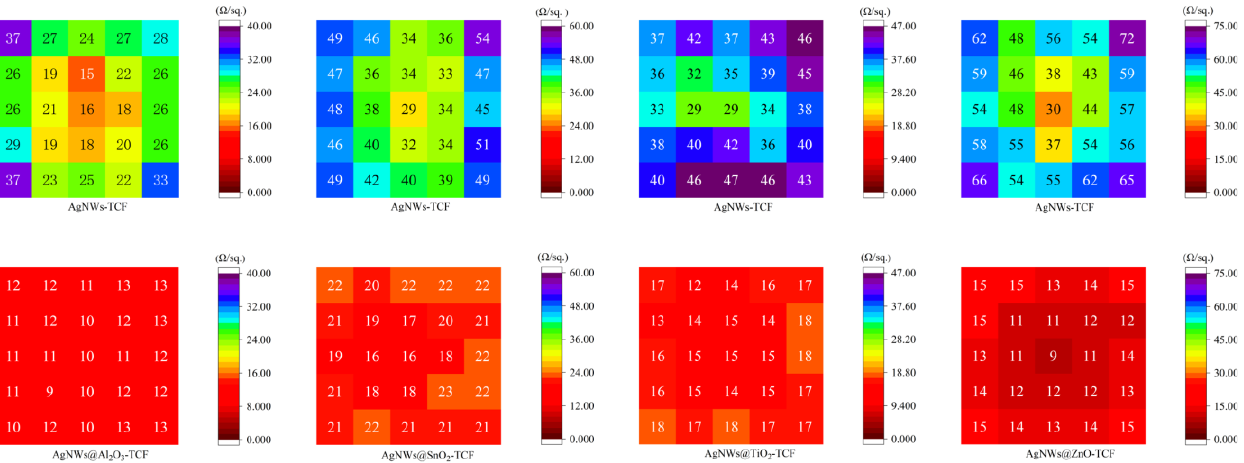
Figure 2. The sheet resistance of AgNWs-TCFs before and after MONPs modification. The inset ( a ) is the physical diagram of bare AgNWs-TCFs resistance test location, and inset ( b ) is the physical diagram of AgNWs @TiO 2 -TCFs resistance test location.